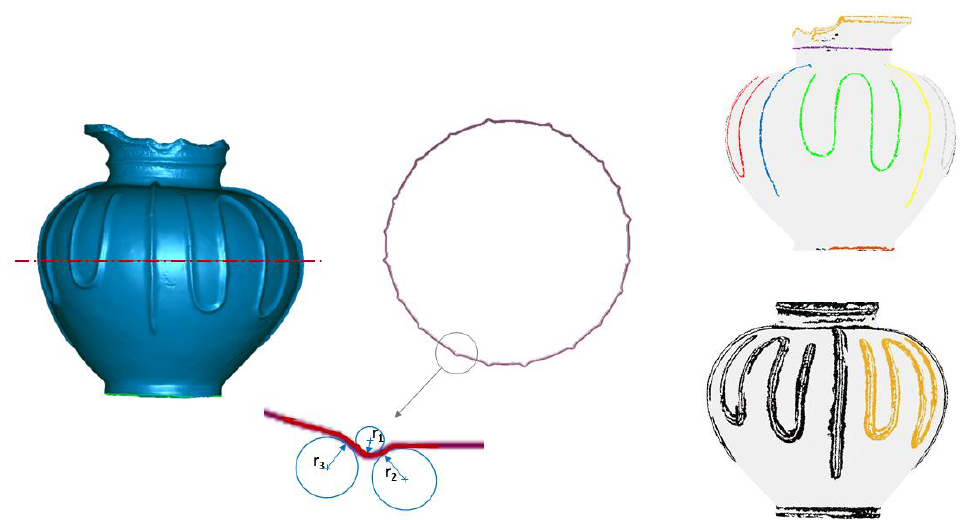
Figure 8. CRS segmentation of an archaeological pot. The different colors are used to highlight the non-adjacent CRS features [4].